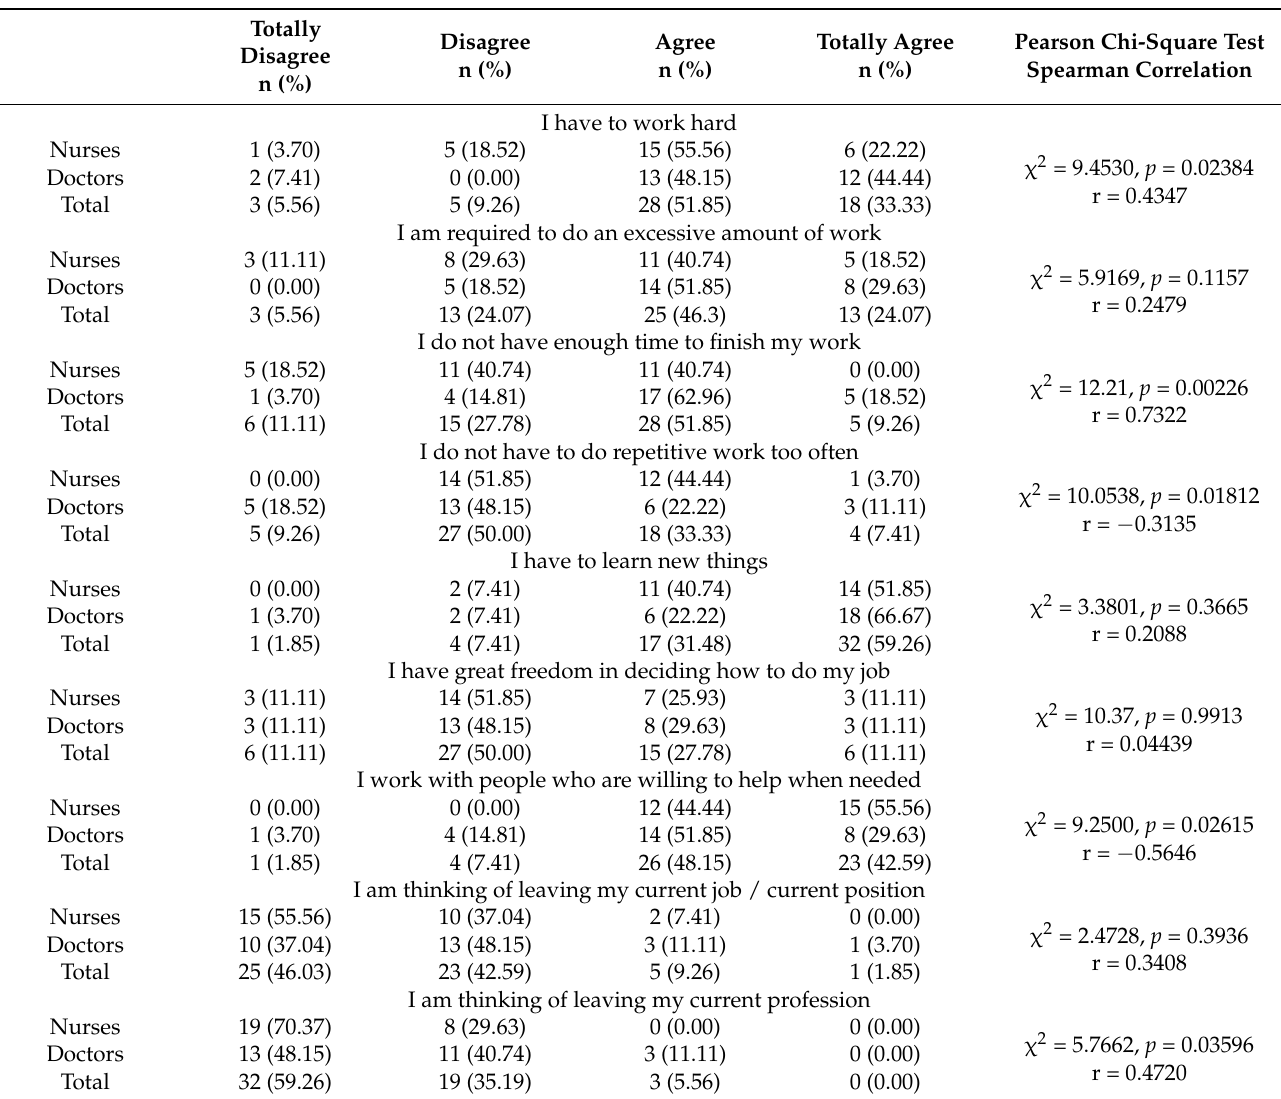
Table 1. Workplace